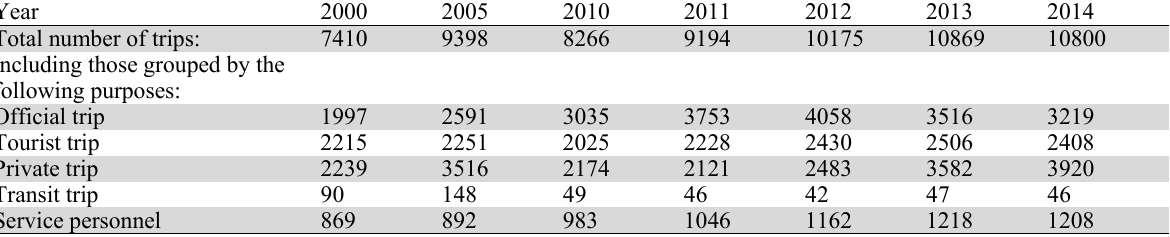
Table 2 The dynamics of trips to Russia grouped by purposes (excluding former Soviet Union countries), thou- sand